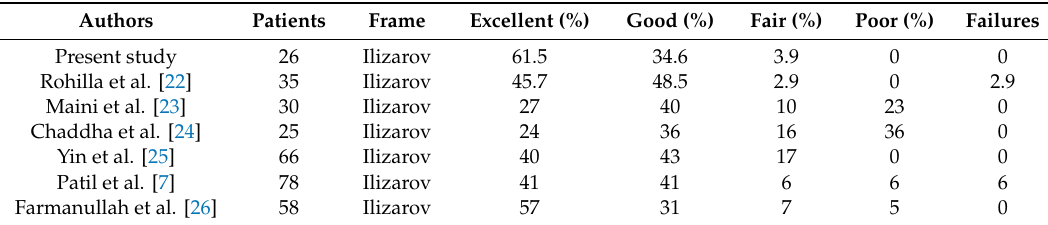
Table 8. Comparison between the results of the di ff erent studies using the ASAMI Functional Scoring